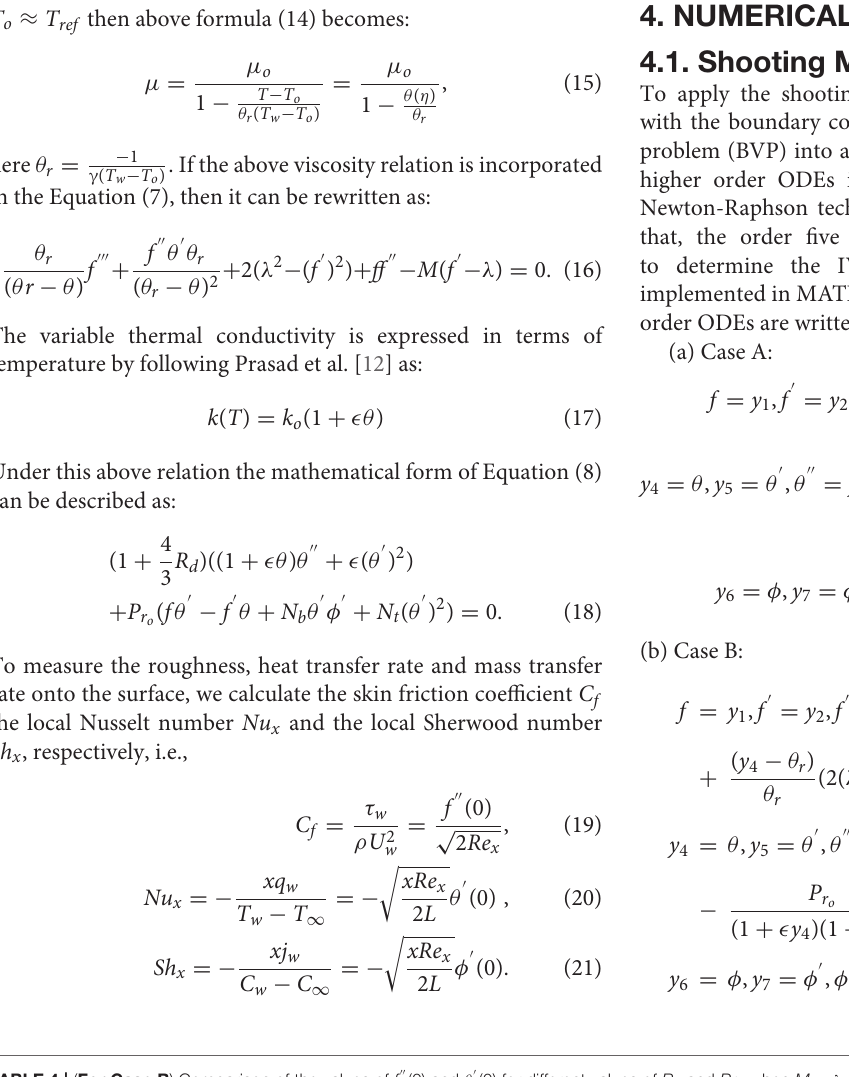
TABLE 4 | ( For Case B ) Comparison of the values of f ′′ (0) and θ ′ (0) for different values of R d and Pr 0 when M R d Pr